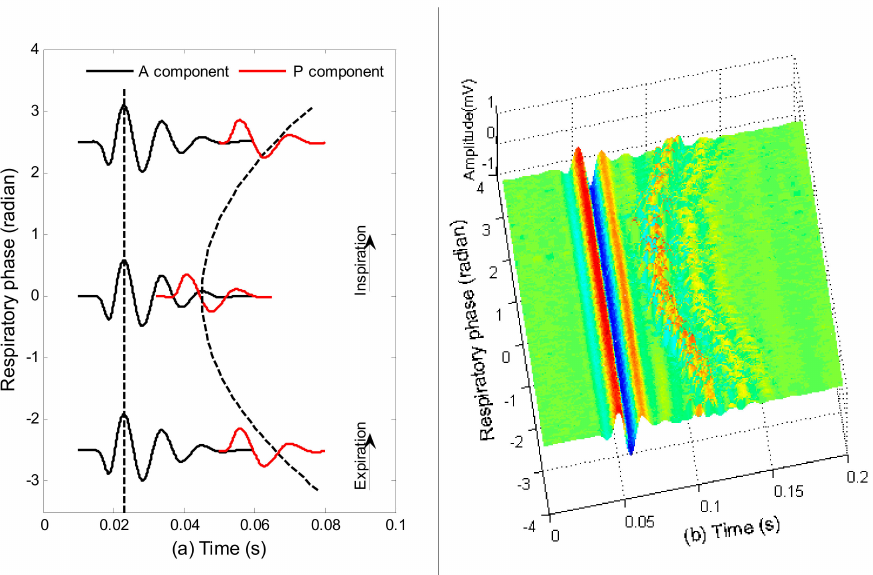
Figure 2. Illustration of the respiratory variation in spitting of the second heart sound. ( a ) Diagram of the variations. The dash lines are used as a time reference. ( b ) A real example to show the respiratory variations based on data collected from a healthy